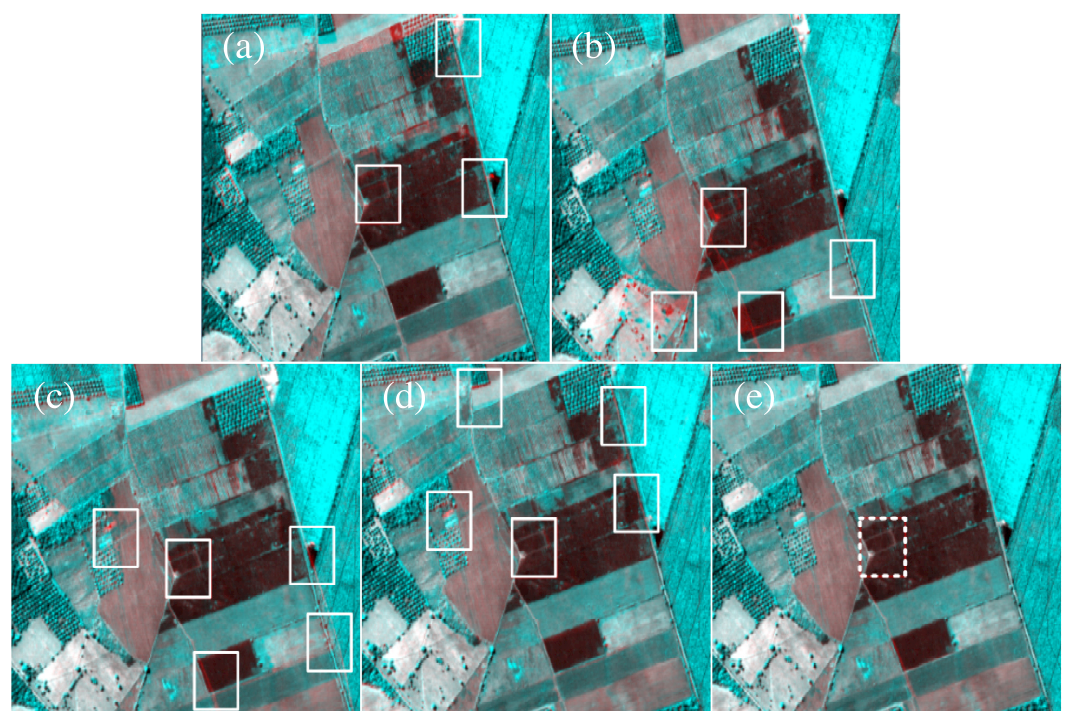
Figure 9. Samples of pseudo RGB images of Dataset 3: ( a ) SIFT; ( b ) SURF; ( c ) SSD; ( d ) NCC; and ( e ) FZNCC. The white box indicates inaccurately registered area.